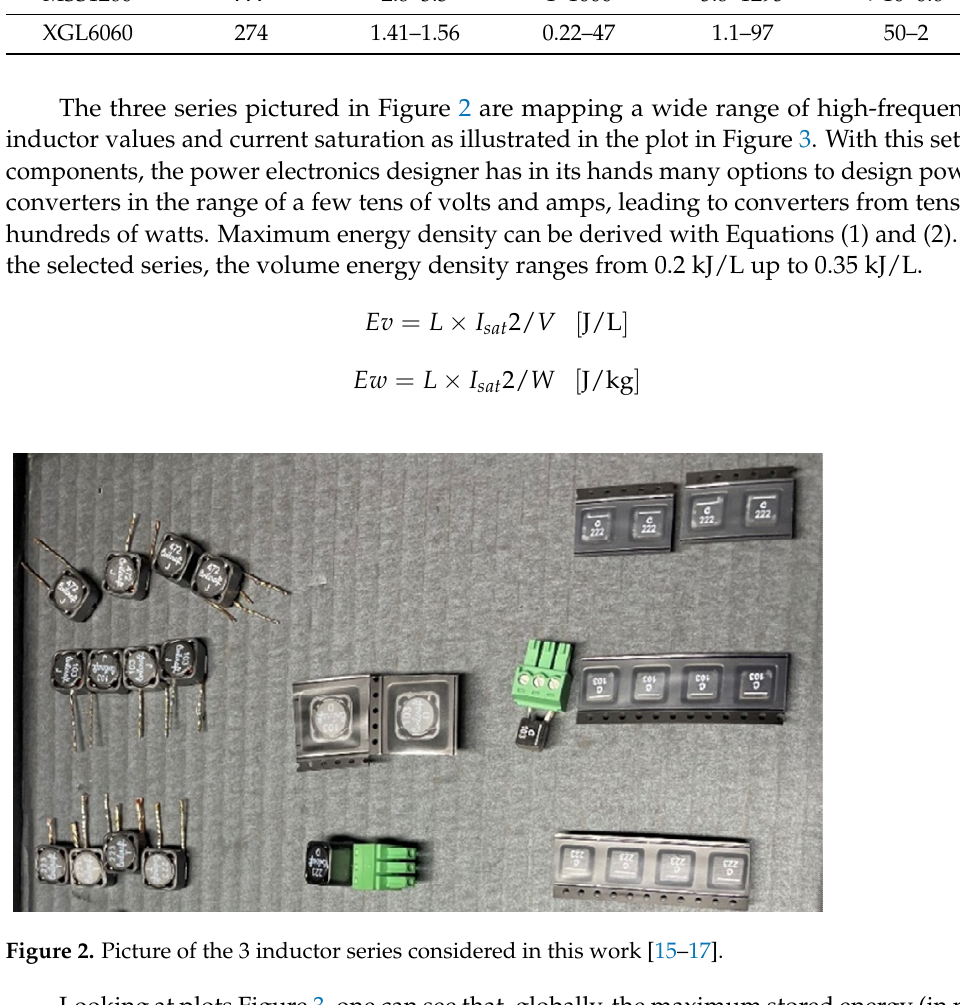
relevant parameters are summarized in Table 1 below. These three series were chosen for their advanced features such as low ESR, high-frequency working capacity, low volume and their wide range of use. A wide range of inductance values can be seen in each series. They are also declared by the manufacturer as using their most advanced technology. Table 1. The main characteristics of the three inductor series considered in this work [15–17].